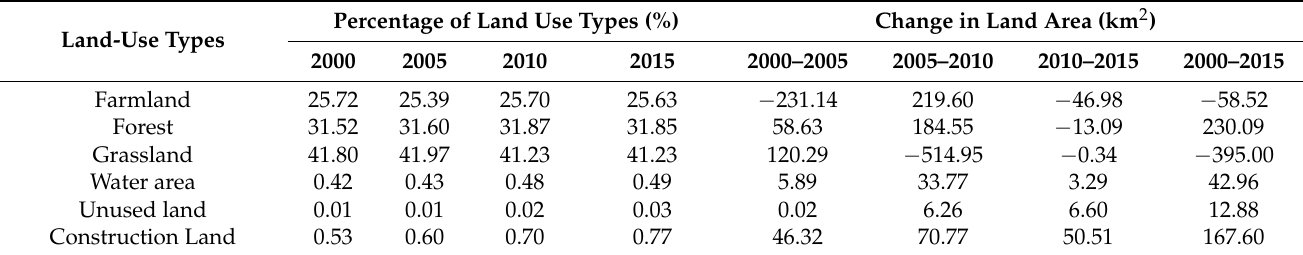
Table 5. Changes in land use types in the Qinba Mountains from 2000 to